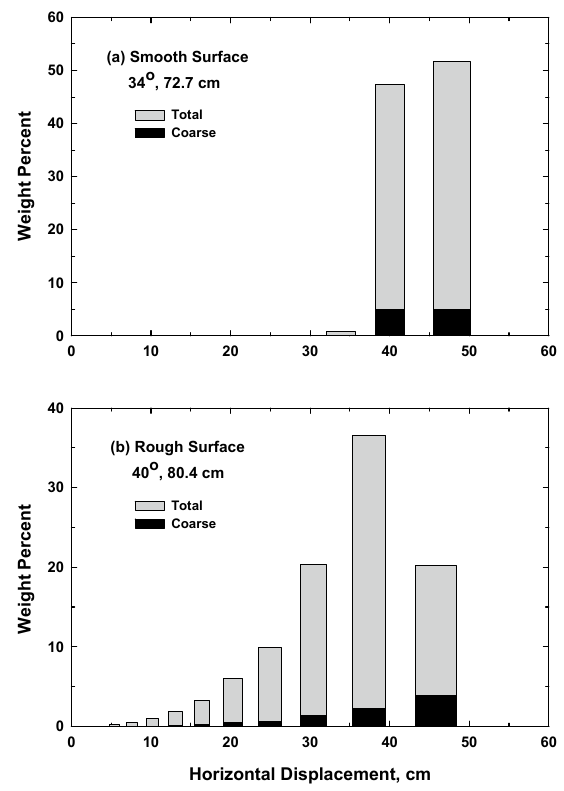
Fig. 1 Distribution of trajectories for mixtures of coarse (30 × 40 US mesh) and fine (70 × 100 US mesh) particles projected from in- clined chute surfaces. Data of Augenstein 19) .